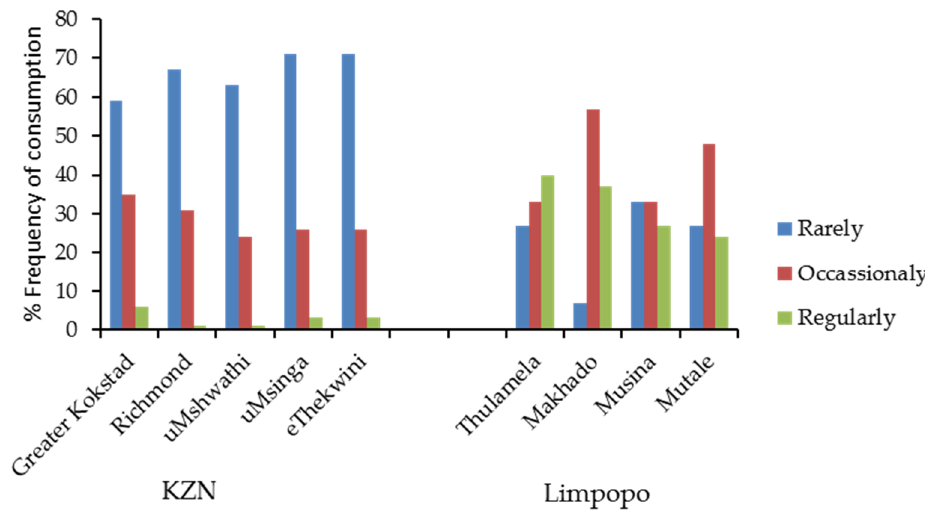
Figure A2. Frequency of insect consumption per week and month across municipalities in KwaZulu-Natal and Vhembe district, Limpopo. Rarely consume insects (at least once a month), occasionally (1–4 times a month), regularly (1–4 times a week). Table A1. Number of villages sampled in different local municipalities in Limpopo and KwaZulu- Natal.